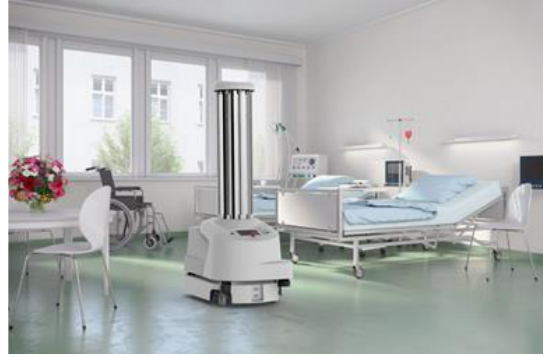
Figure 1. Blue Ocean Robotics MODEL C.